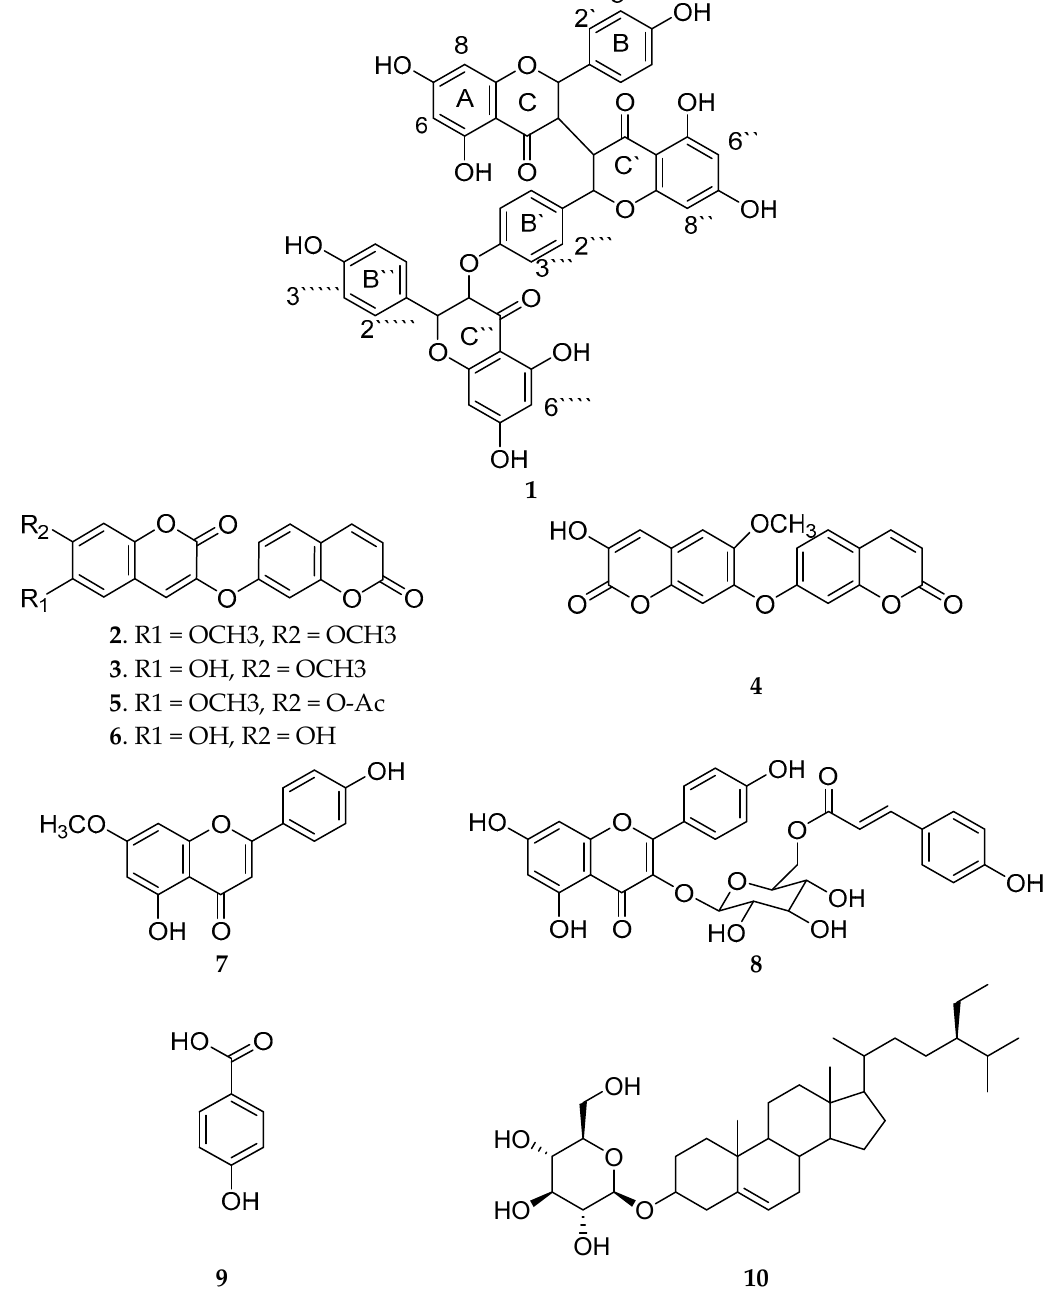
Figure 1. Structure of isolated compounds 1 – 10 .